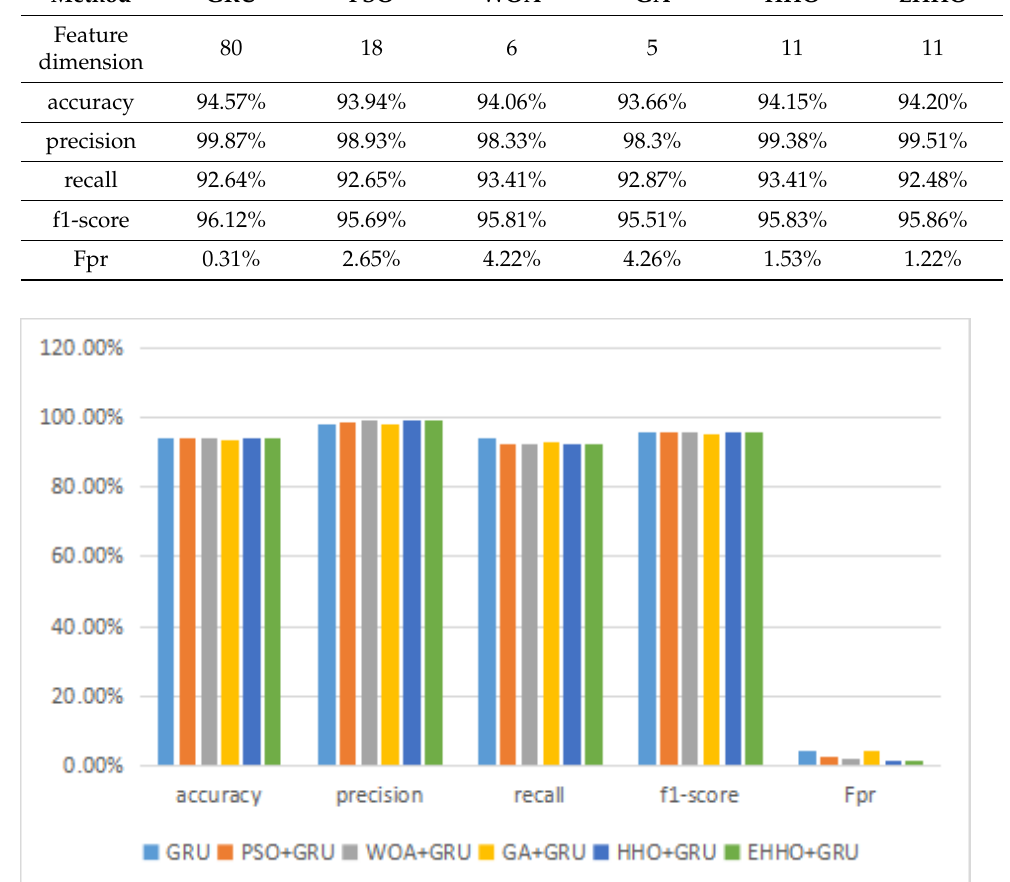
Figure 13. Binary classification histogram of CICIDS2018.